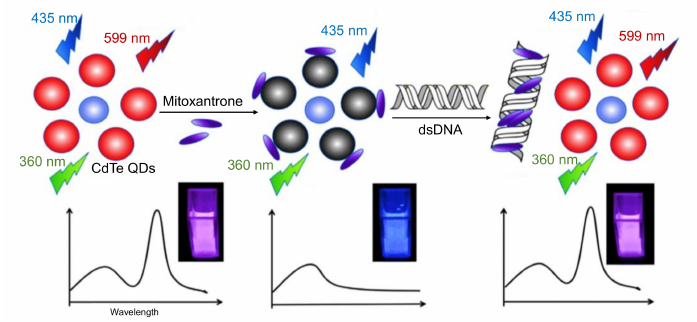
Figure 18. An example of fluorescence-based dsDNA detection method, using CdTe QDs/CDs/mitoxantrone complex. Reproduced from [260], with permission from Elsevier, 2017. Liao and co-workers carried out hydrothermal synthesis of N-CDs from urea